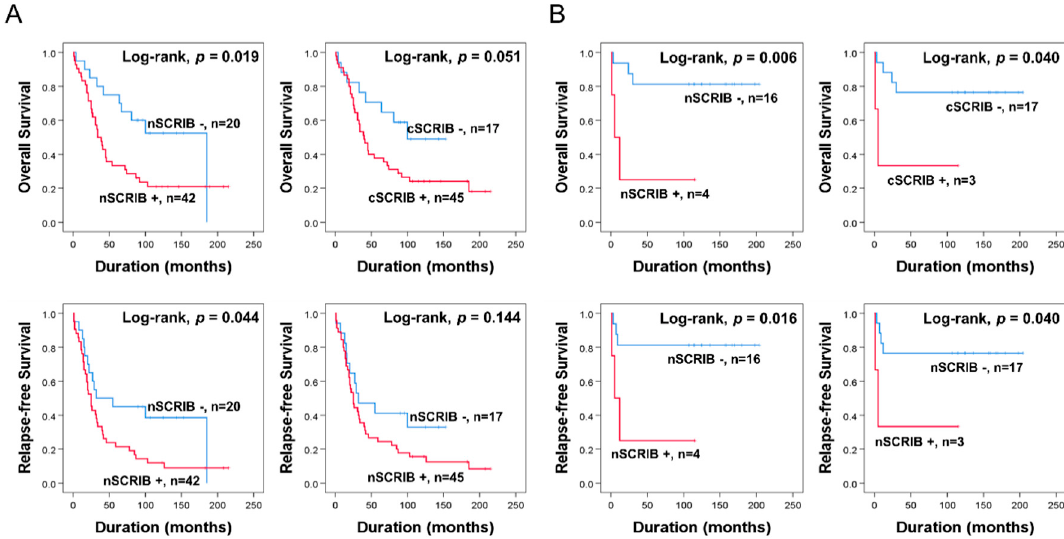
Figure 3. Kaplan-Meier survival curves in 62 HGSCs ( A ) and 20 mucinous carcinomas ( B ). 3.3. Nuclear Expression of SCRIB Predicts Shorter Survival of Ovarian Carcinoma Patients in Multivariate Analysis The factors significantly associated with OS or RFS in univariate analysis except for CA125 level were included in multivariate analysis. In overall 104 ovarian carcinomas, age, cancer stage, histologic grade, and nSCRIB were associated with OS or RFS (Table